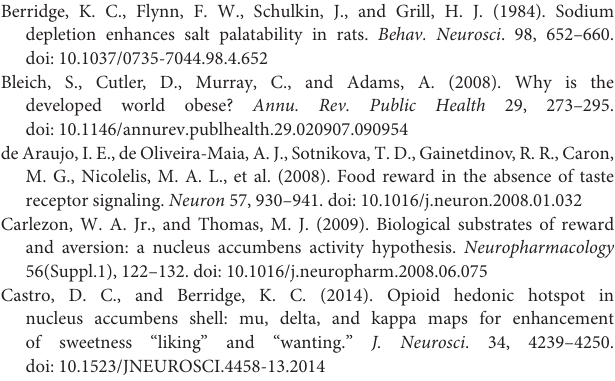
Figure S1 | Representative locations of recording sites. Schematics (left) of coronal sections of the rat brain highlighting, in red, the areas recorded from all rats. The photograph on the right side shows a representative example of a coronal brain section ( ∼ 1.2mm from bregma) where two electrode tracks (upper) and a recording site (see magnification below, arrow) targeting the NAcSh are seen. CC, corpus callosum; aca, anterior commissure. Figure S2 | Extracellular recordings of a Palatability-related neuron that was putatively recorded across three consecutive days. (A) The blue waveforms are all the action potentials of a single neuron recorded in the NAcSh during a Start test session. Gray traces are the unsorted waveforms (noise signal) recorded from the same channel. (B) The same action potentials (blue points) of the neuronal activity depicted in A within the 55-min session. Values are plotted in a three-dimensional space built with the first two principal components (PCs) of the waveforms vs. time. (C) Inter-Spike Intervals (ISIs) histograms (blue bars) of single-unit activity recorded from the same electrode during three consecutive days. Insets depict the average waveform. (D) Raster plots (upper panels) and PSTHs (lower) of the neuron shown in C with their responses aligned (Time = 0s) to the RS. Note that in the three days this neuron was inhibited preceding licking initiation and fired more in the water and 3% sucrose trials. Same conventions as in Figure 4. Briefly, black ticks depict the action potentials as a function of the color-coded sucrose concentrations. The horizontal blue lines separate Complete from Incomplete trials. The licking responses are shown in red ticks. Figure S3 | In the three tests, Palatability-related and Lick-Inactive neurons were more overlapped. Contingency tables showing for each brief-access test the number (%) of neurons that belong to two different NAcSh populations. For each square in the contingency table, a Fisher’s exact test was performed. Values in bold indicate that the probability of overlapping was statistically different than chance (Fisher’s exact test; p < 0.05). The color code means the amount of overlap where 100% corresponds to the total number of neurons in each pair of neuronal populations. The “n” in parenthesis shows the total number of neurons belonging to each population. Figure S4 | The firing rate of the Palatability-related neurons during their “best-window” is sufficient to track the changes in lick rate over the course of the session . Population PSTHs of the firing rate during the “best-window” of each Palatability-related neuron as a function of the progress over the session and sucrose concentration. Upper panel shows neurons with increasing and lower panels with decreasing firing rate as a function of sucrose concentration. Similar results are found using the firing rate in the entire Reward epoch (see Figure 8A ). Table S1 | Number of single-units recorded per